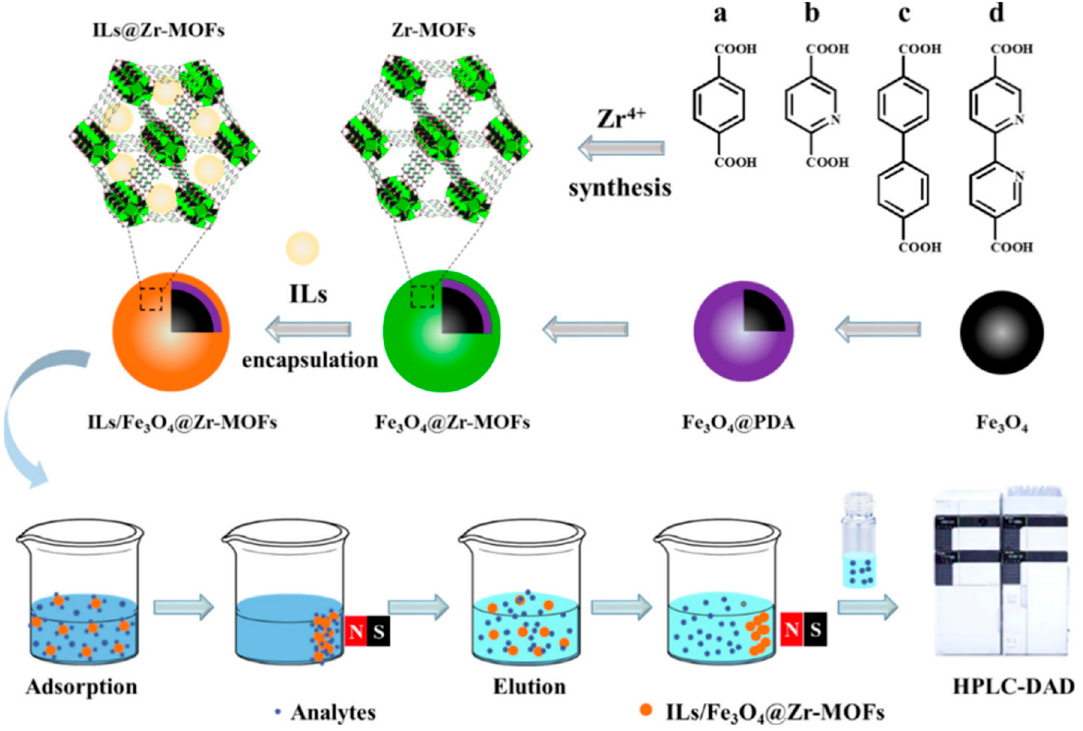
Figure 12. Preparation of ILs/Fe 3 O 4 @Zr-MOFs and MSPE Process. Reprinted with permission from Ref. [111]. Copyright (2021) American Chemical Society.